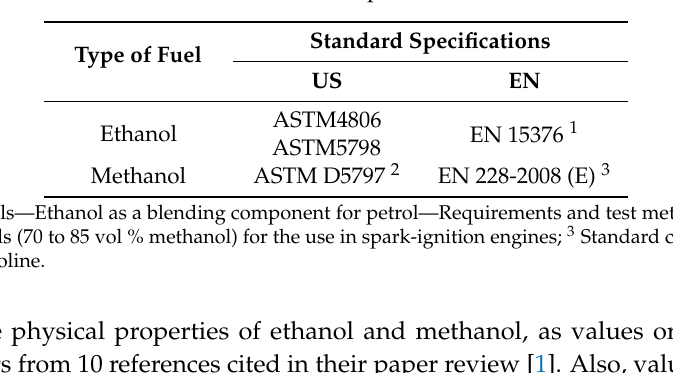
Table 5. Standard Specifications.